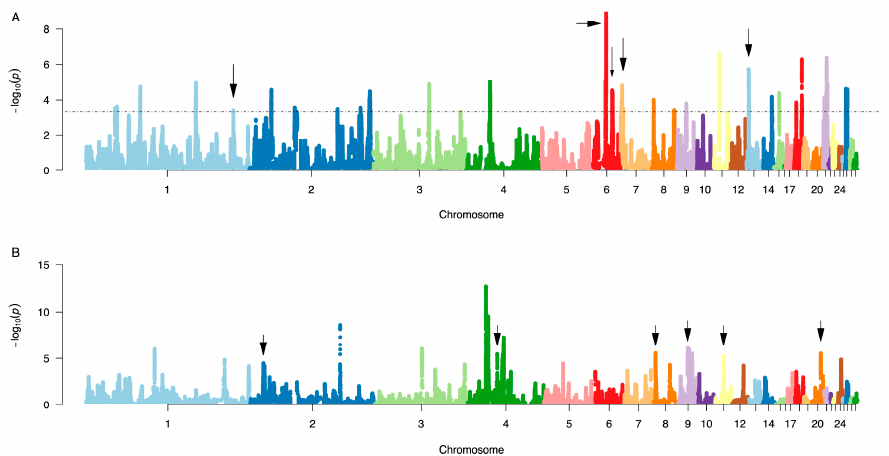
Figure 1. Genome-wide scans for regions with significant haplotype changes. ( A ) LW and ( B ) HW selected Virginia chicken lineages. Purging regions (see 3.2. below) are highlighted by black arrows.